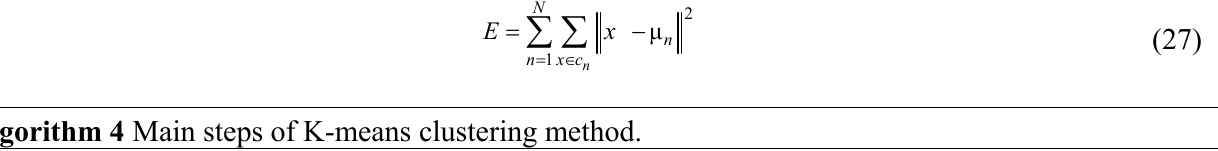
Algorithm 4 Main steps of K-means clustering